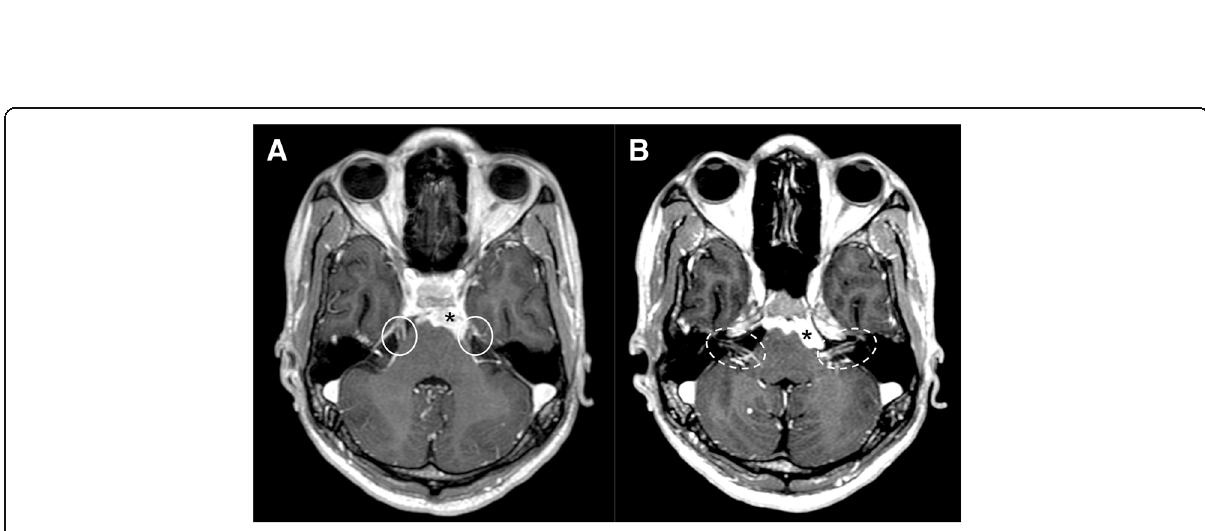
Fig. 28 Tuberculosis (TBC). MRI T1-weighted post-gadolinium axial image demonstrates pathologic enhancing tissue involving the basal cistern and ventral surface of the brainstem (asterisks), with leptomeningeal enhancement of bilateral trigeminal ( a , circles), facial, and vestibulocochlear nerves ( b , dotted